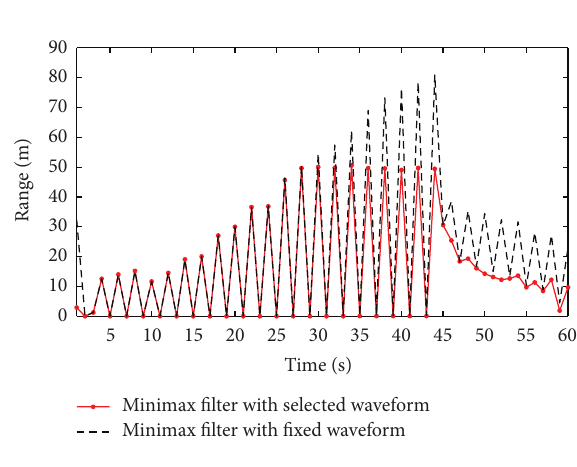
Figure 4: Estimation